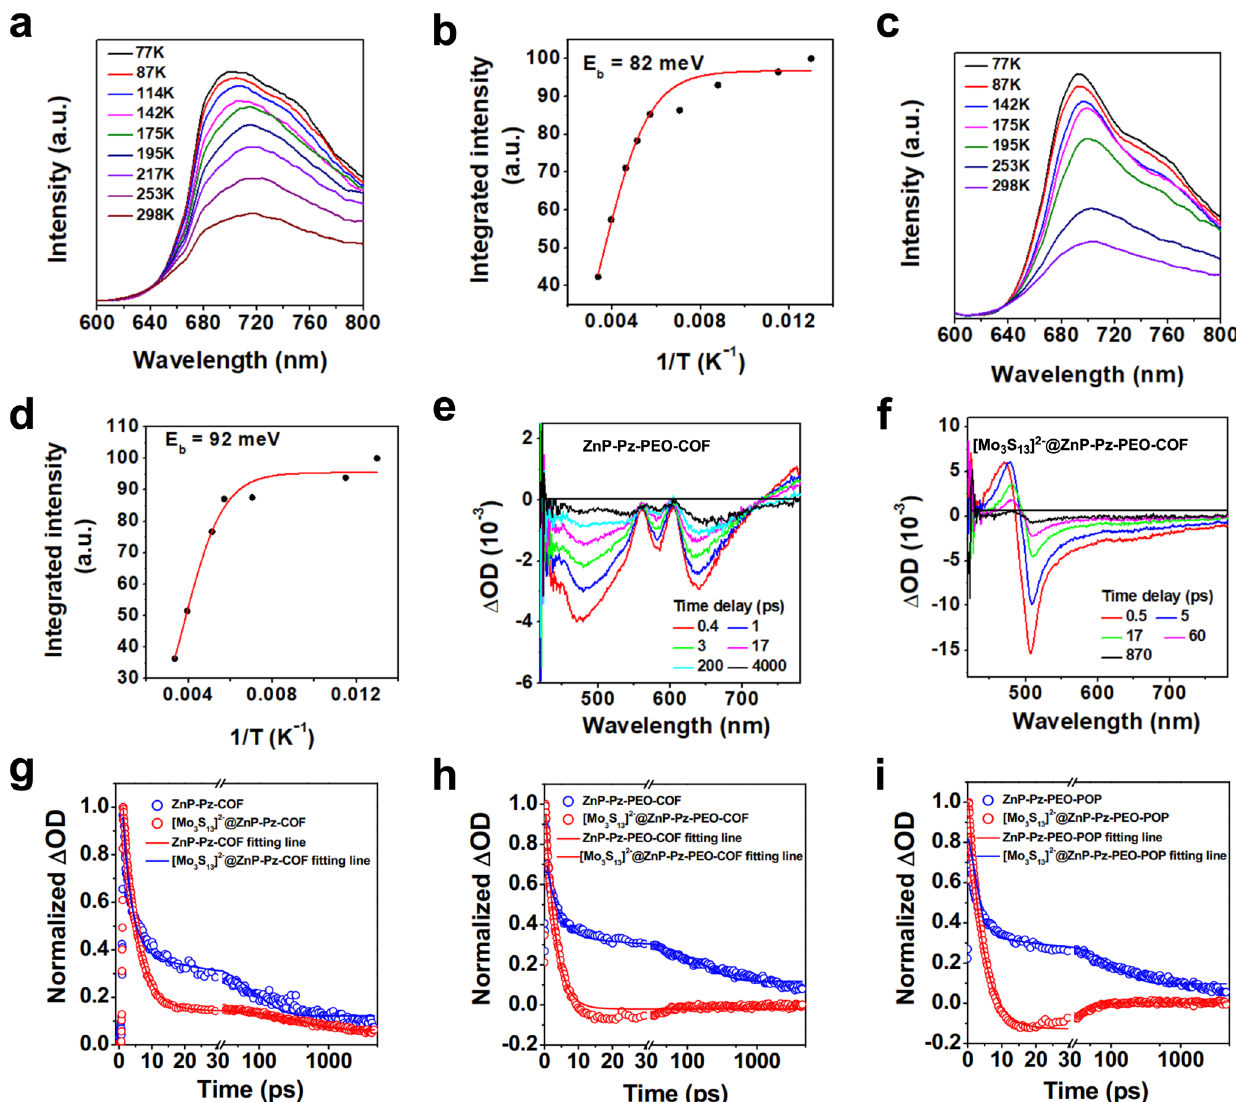
Fig. 6 | Photophysical property. a Temperature-dependent photoluminescence spectra of ZnP-Pz-PEO-COF with excitation wavelength at 580nm. b Extracted exciton binding energy of ZnP-Pz-PEO-COF. c Temperature-dependent photo- luminescence spectra of ZnP-Pz-PEO-POP with excitation wavelength at 586nm. d Extracted exciton binding energy of ZnP-Pz-PEO-POP. Femtosecond transient absorption spectra of e ZnP-Pz-PEO-COF and f [Mo 3 S 13 ] 2 – @ZnP-Pz-PEO-COF,